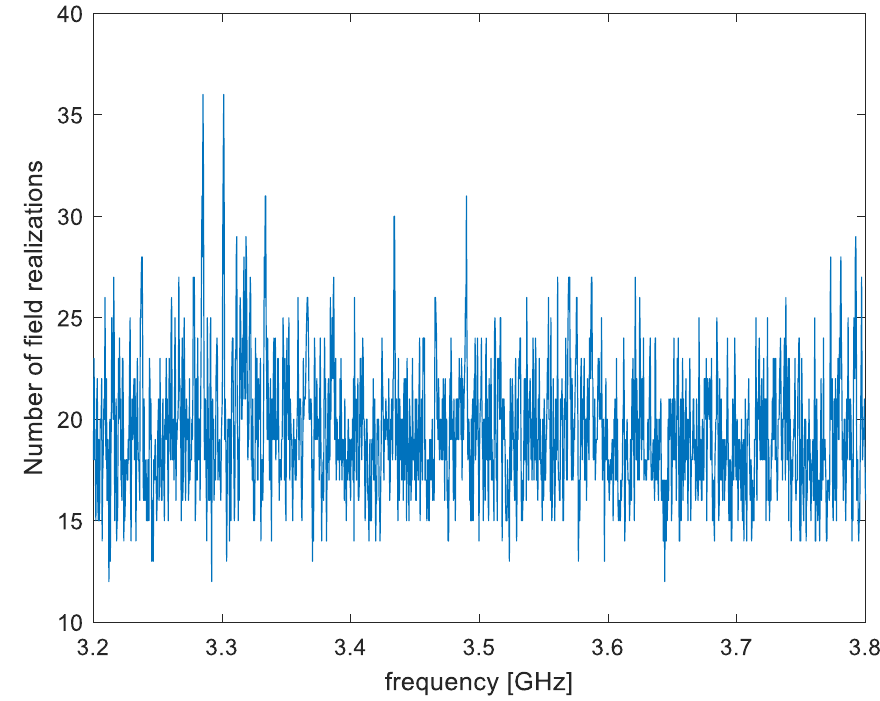
Figure 11. Number of field realizations selected by the algorithm in the frequency band 3.27 – 3.80 GHz .